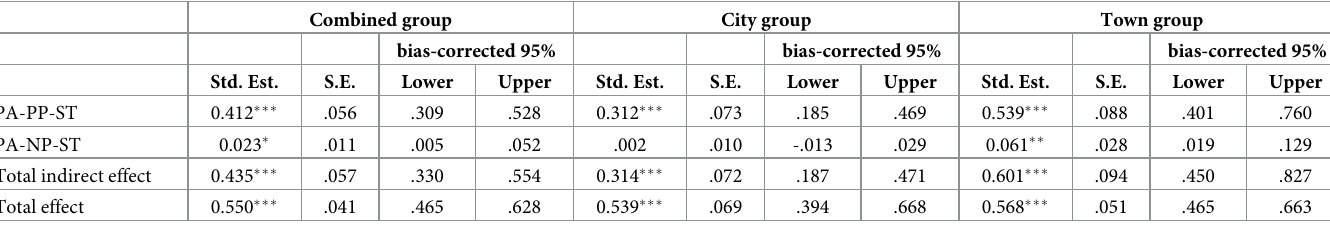
Table 9. Results of mediation